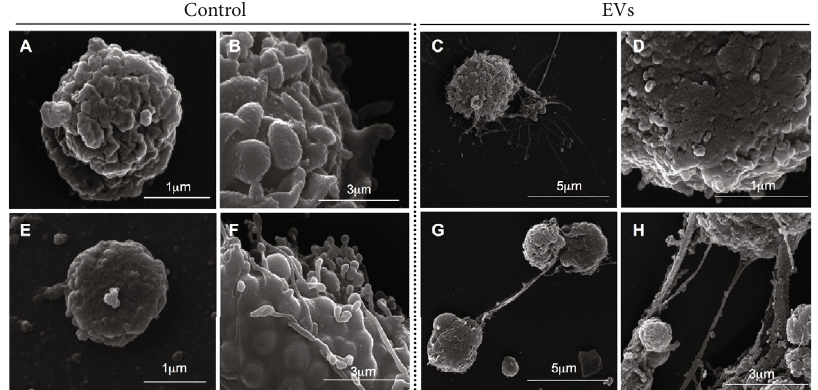
Figure 2: Scanning electron microscopy (SEM) of CCD PBMCs releasing EVs after 24 and 48h of parasite EV stimulus. 24 h control in (a, b), 48h control in (e, f), 24 h parasite EV stimulus in (c, d), and 48h parasite EV stimulus in (g,